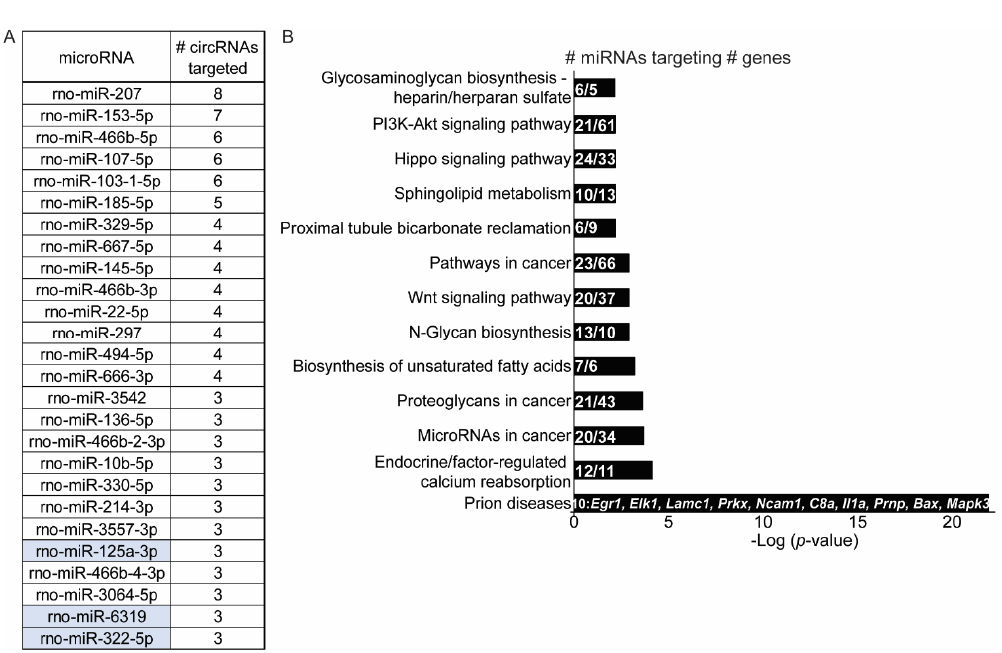
Figure 6. A predicted circRNA–miRNA network in the OFC associated with heroin exposure. ( A ) List of miRNAs predicted to target at least 3 heroin-associated circRNAs identified in the microarray analysis. Highlighted miRNAs target circRNAs validated with qPCR. ( B ) Pathway analysis of the target genes of miRNAs listed in ( A ). For each significant pathway, the number of miRNAs that target the pathway is listed, as well as the number of genes in the pathway that the miRNAs target.